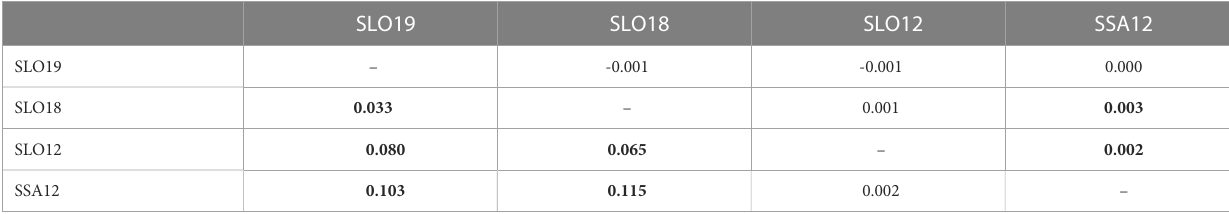
TABLE 5 Pairwise F ST matrix for Cerastoderma edule samples collected in 2012 (NS: naive) and in the 2018/19 period (AS: affected) in the R ı ́ a de Arousa, Galicia (NW Spain).